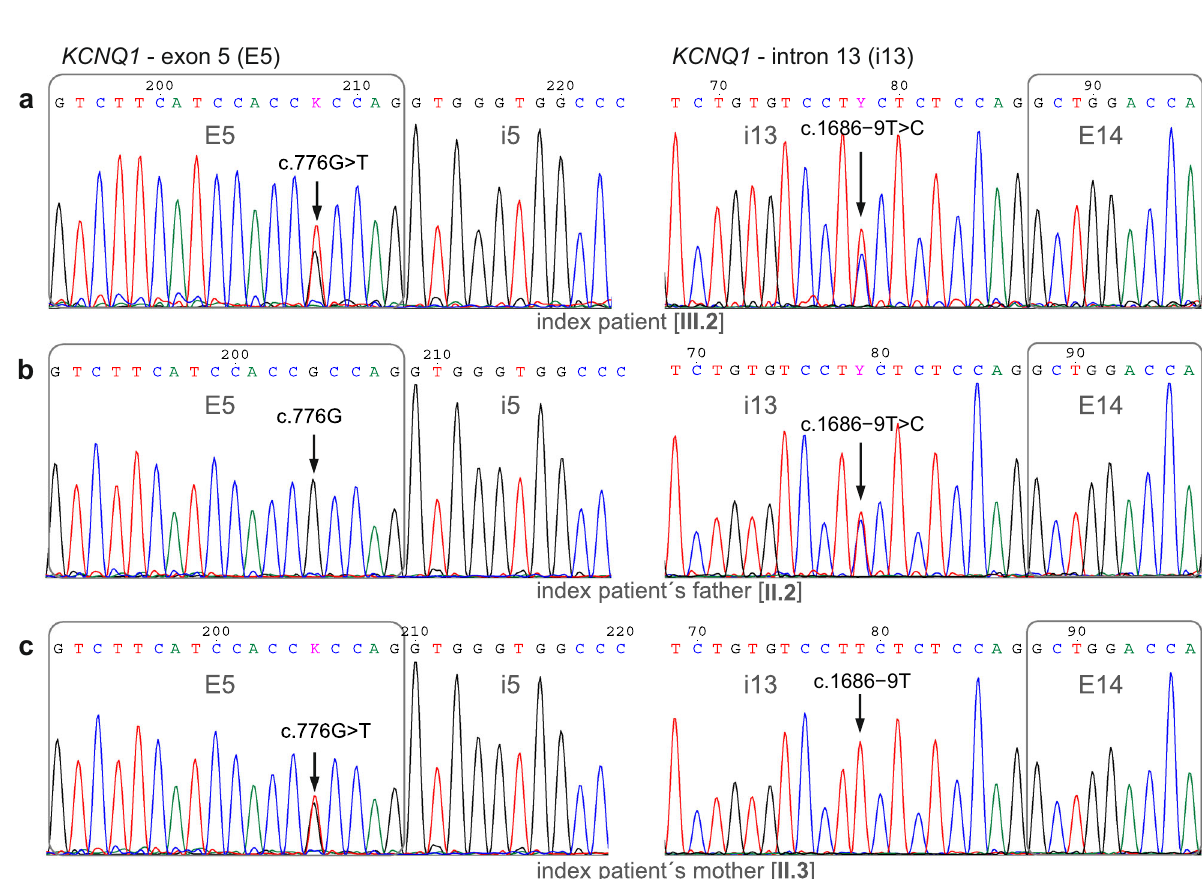
Fig. 3 Parental origin of the pathogenic c.776 G > T and the candidate c.1686 − 9 T > C KCNQ1 variants identi fi ed in the index patient. DNA sequencing chromatograms of the KCNQ1 gene exon 5 (left) and intron 13 (right) from the index patient ( a ), father ( b ), and mother ( c ). The index patient ’ s variant c.776 G > T in exon 5 was detected in his mother, whereas the c.1686 − 9 T > C variant in intron 13 was detected in his